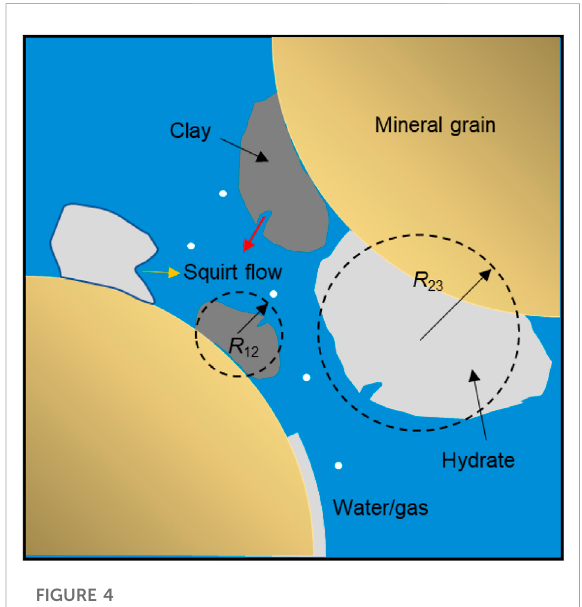
FIGURE 4 Schematic diagram of the proposed triple-porosity